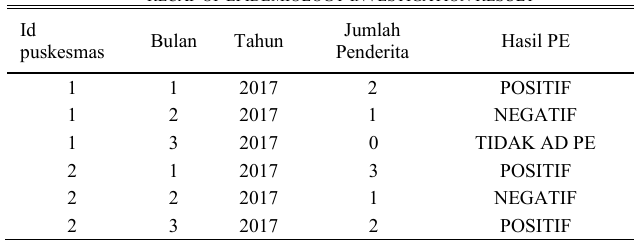
TABLE 2 RECAP OF EPIDEMIOLOGY INVESTIGATION RESULT